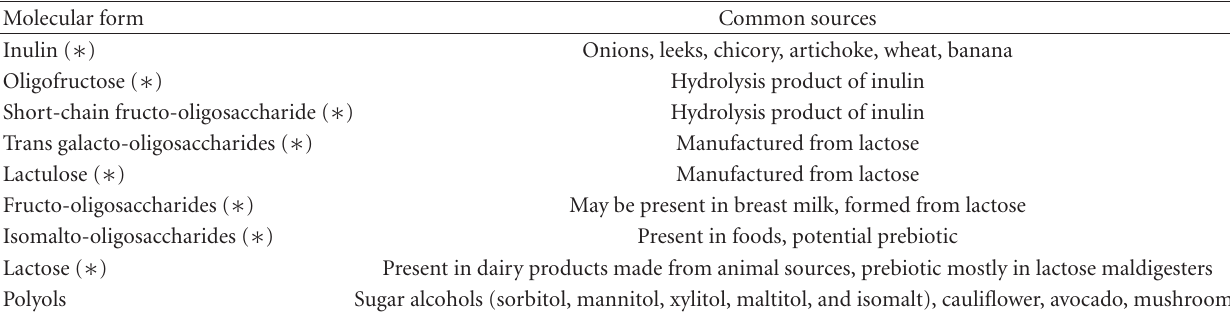
Table 1: List of poorly digested carbohydrates comprised of FODMAP and select prebiotics ( ∗ ), as well as their respective sources. This is not a complete list, and other complex carbohydrates which have e ff ects on bacteria are also included in